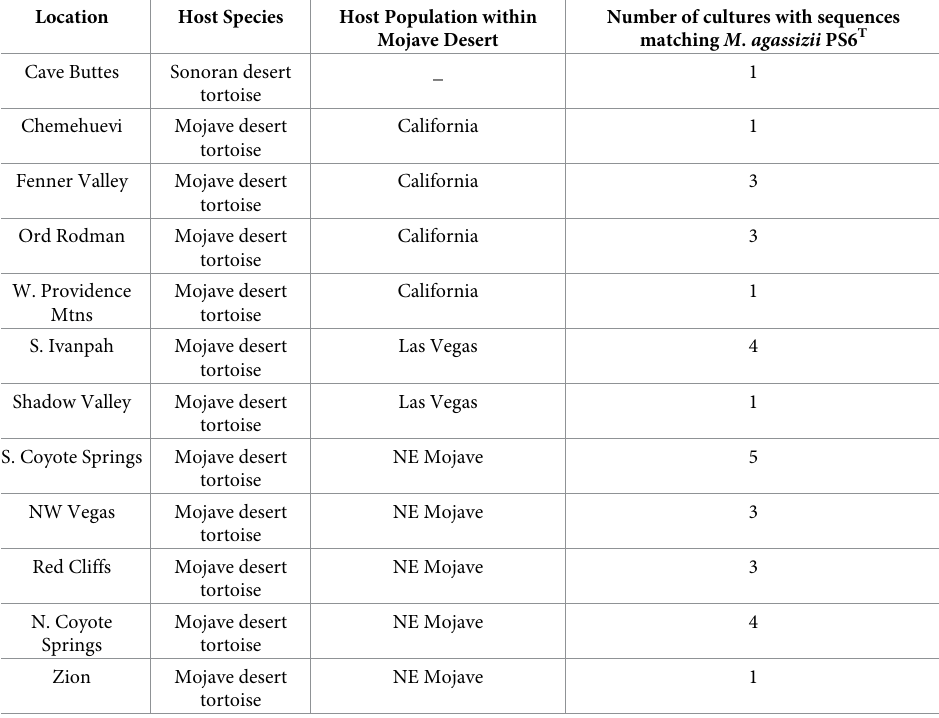
Table 2. Very low coverage genomes originated from 11 populations of Mojave desert tortoises ( Gopherus agassi- zii ) and one population of Sonoran desert tortoises ( Gopherus morafkai